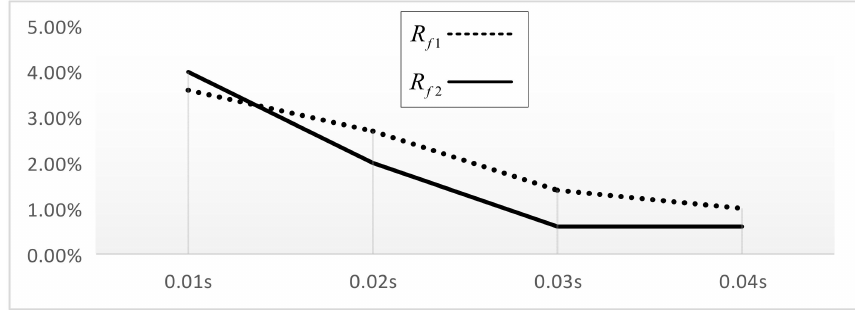
Figure 10. Waveform of grounding current with di ff erent values of C Y . ( a ) C Y = 0.1 µ F. ( b ) C Y = 0.2 µ . ( c ) C Y = 0.4 µ F.